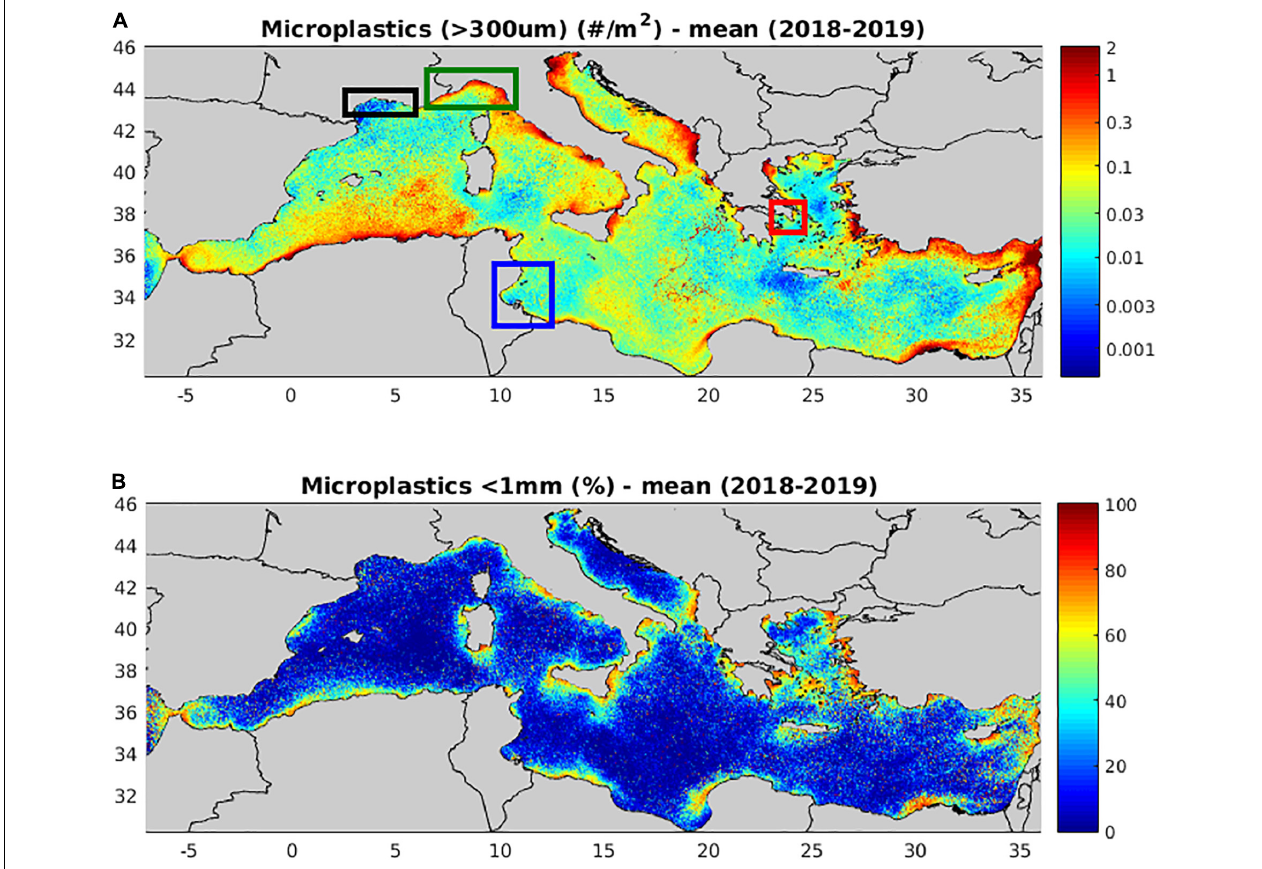
FIGURE 1 | Mean (2018–2019) simulated microplastics (A) concentration (items/m 2 ) and (B) contribution < 1 mm (%). The four key study areas are indicated (black box, Gulf of Lion; blue box, Ligurian Sea; green box, Gabes Gulf; and red box, Saronikos